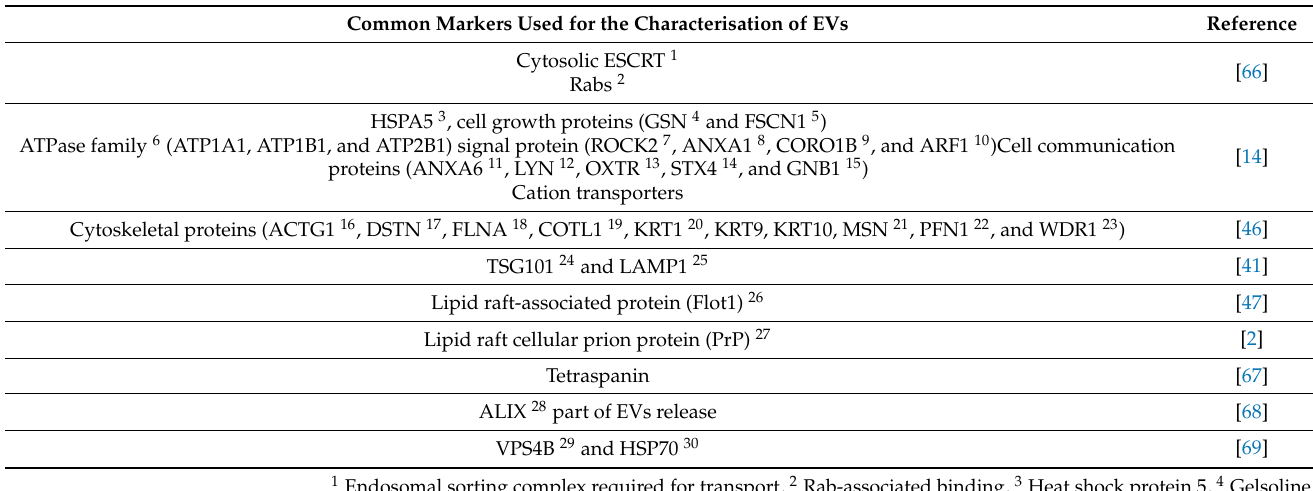
Table 1. Common EV protein cargo is often used as EV markers. Common Markers Used for the Characterisation of